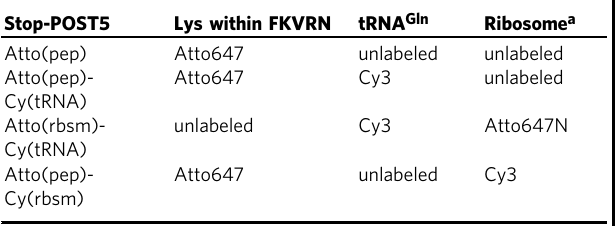
Table 2 Sites of fl uorophore incorporation within fl uorescent Stop-POST5